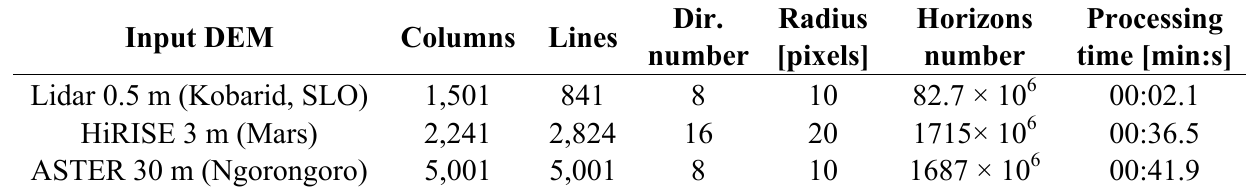
Table 1. Sky-view factor computation